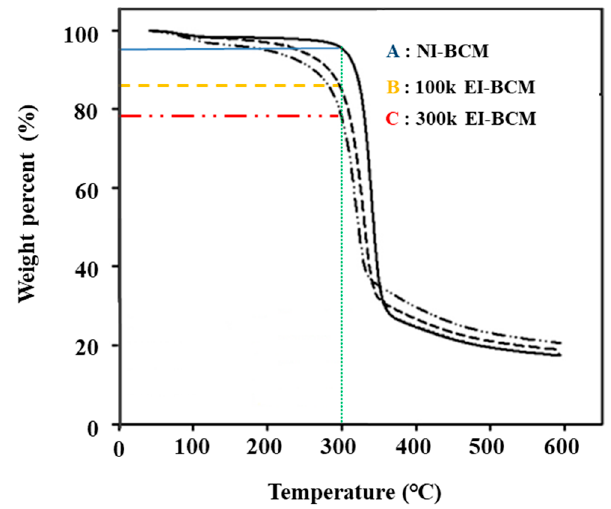
Figure 3. ATR-FTIR spectra of A : NI-BCM, B : 100k EI-BCM and C : 300k EI-BCM. The results obtained indicated that cleavage occurred in the main chain of the BC through change of chemical characteristics.